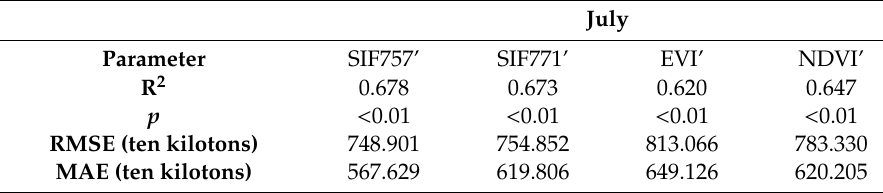
Figure 3. The comparisons between autumn crop production estimated by the SIF757’, SIF771’, EVI’, NDVI’, and the government’s autumn crop production statistics in China in 2016 using July data. Production obs (ten kilotons) and production est (ten kilotons) represent production observation and production estimation, respectively.